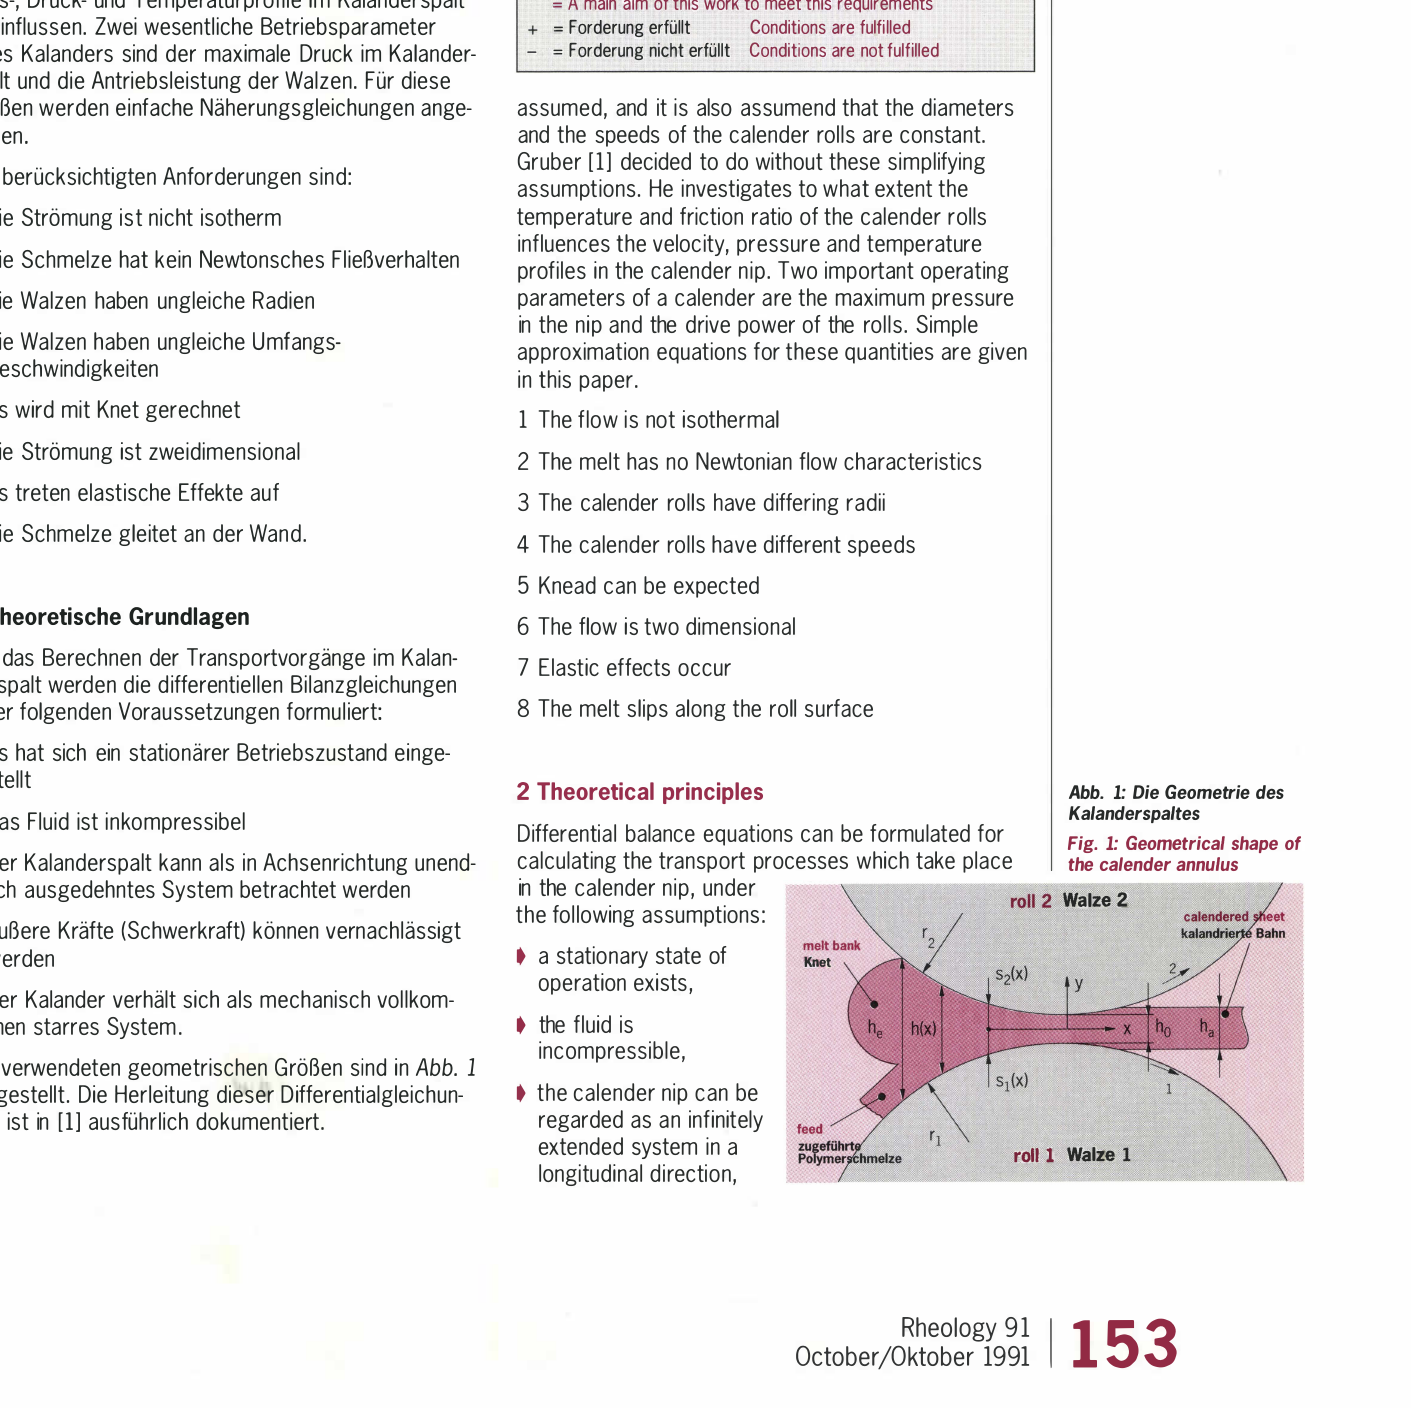
Fig. 1: Geometrical shape of the calender